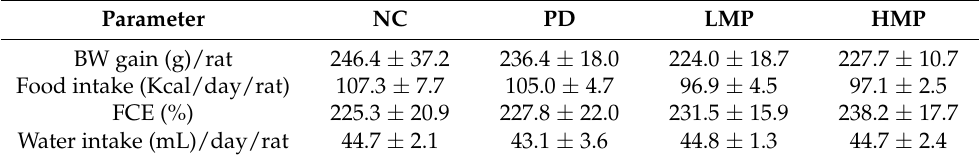
Table 1. Profiles of body weight (BW) gain, food intake, food conversion efficiency (FCE), and water intake after 8 weeks of supplementation in the rat model of